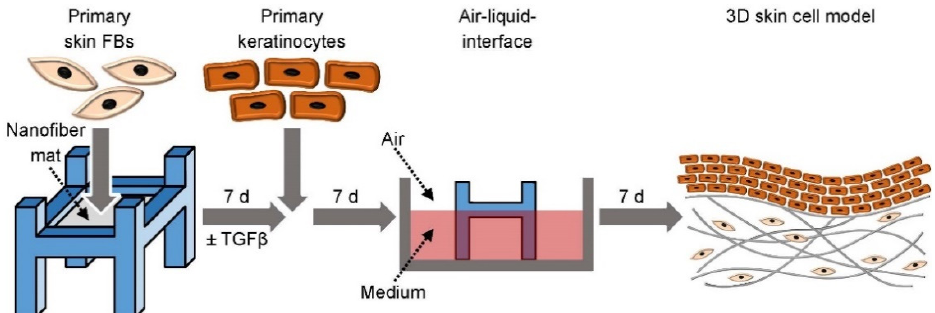
Figure 1. Experimental settings and schedule for skin cell model development: Seeding procedure of primary human skin FBs with or without primary human keratinocytes on electrospun nanofiber mats.